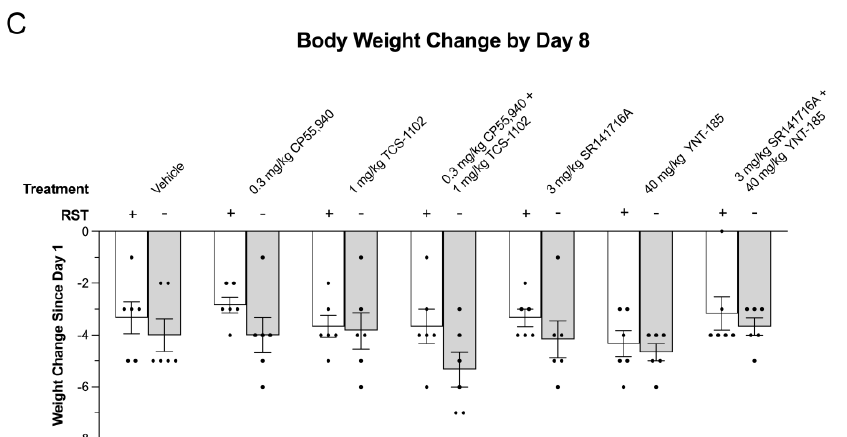
Figure 3. Change in body weight of cannabinoid and orexin drug-treated mice throughout the SPT and 24 h RST. ( A ) Daily change in body weight since day 1 of No 24 h RST groups. ( B ) Daily change in body weight since day 1 of RST groups. ( C ) Body weight change between days 1–8 of all drug and stress treatment groups. ( A – C ) The body weights of adult male and female C57BL/6 mice treated with either 200 µL of vehicle, 0.3 mg/kg CP55,940 (cannabinoid receptor agonist), 1 mg/kg TCS-1102 (DORA), 0.3 mg/kg CP55,940 + 1 mg/kg TCS-1102, 3 mg/kg SR141716A (CB1R antagonist), 40 mg/kg YNT-185 (OX2R agonist), and 3 mg/kg SR141716A + 40 mg/kg YNT-185 were measured in the morning of days 1, 3, 5, 6, and 8. Each day’s body weight was compared to that of day 1. Change in body weight is expressed as (g). n = 6 mice ( n = 3 males; n = 3 females) as each experimental group is reported as a mean ± SEM. Statistical significance for graphs A and B was assessed by a two-way ANOVA followed by a Tukey’s post-hoc analysis with repeated measurements within groups between days and across groups within days. Significant differences within panel C were evaluated via Tukey’s post-hoc analysis without repeated measures. In the figure above “+” refers to with RST and “ − “ refers to without RST.